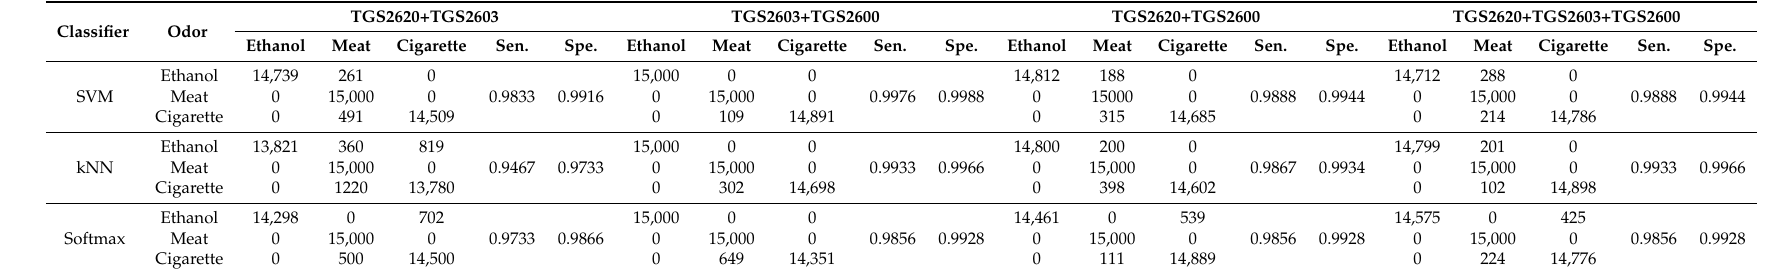
Table 4. Confusion matrix of sensor combination a